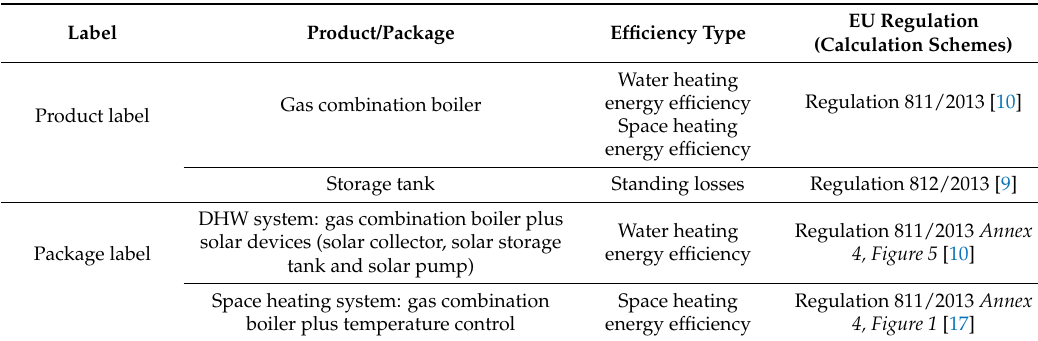
Table 3. Energy label regulations affecting the case study.